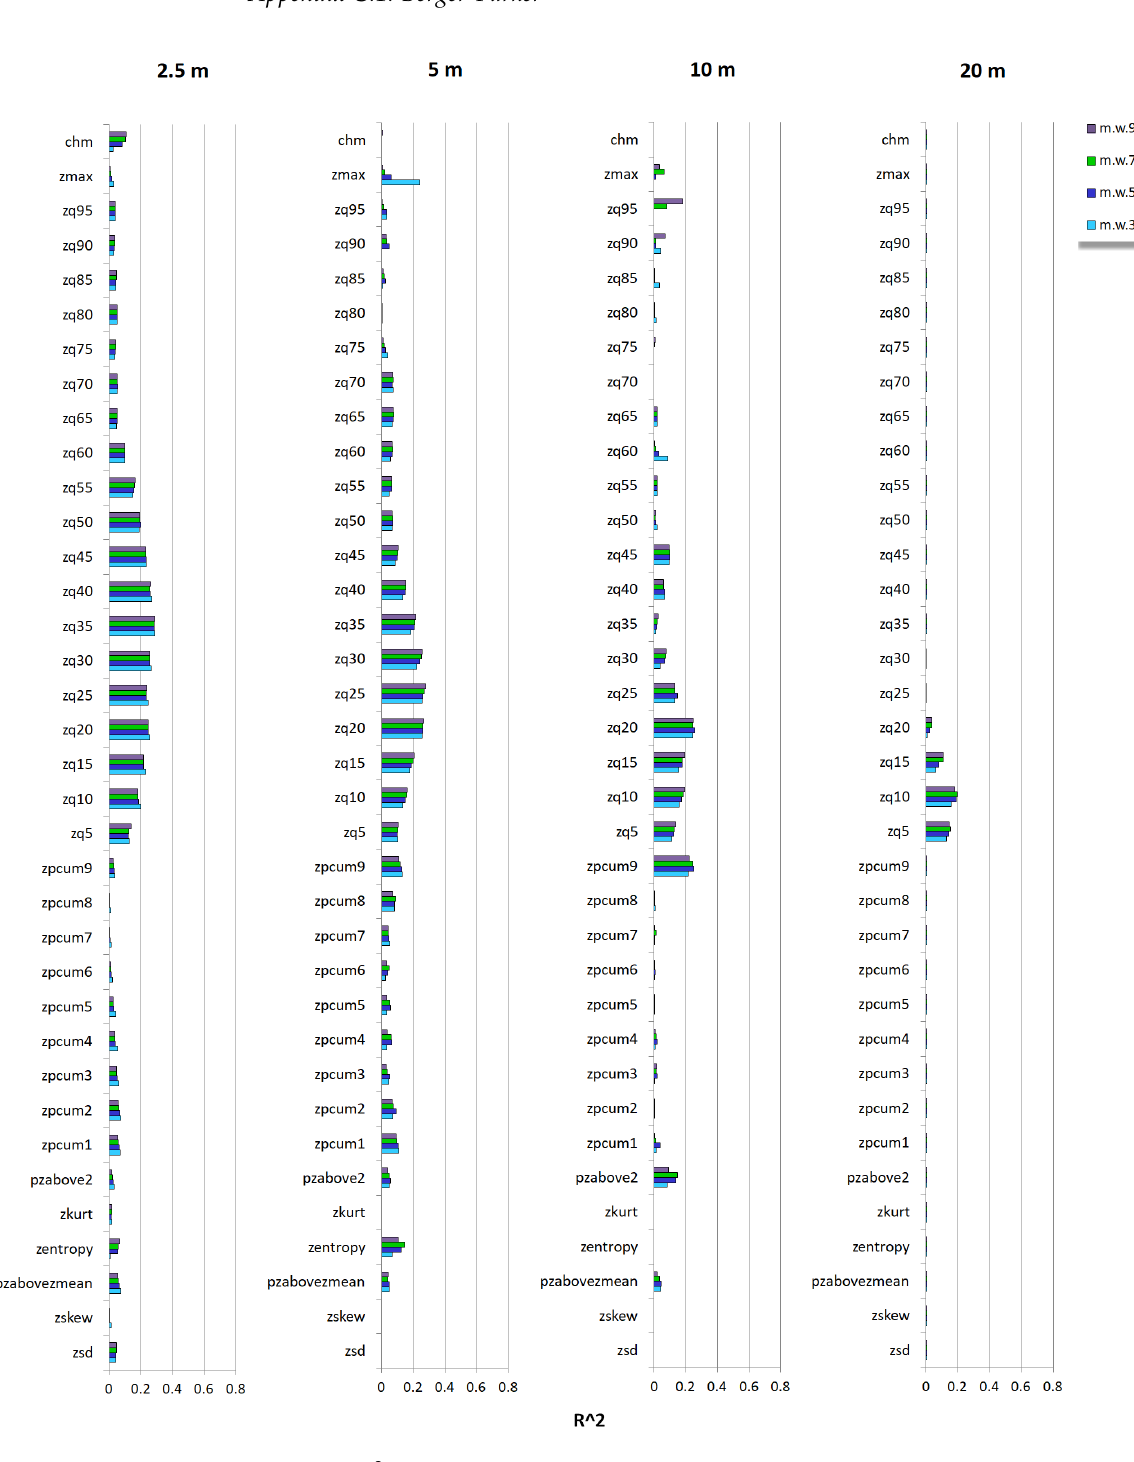
Figure A3. Histograms concerning the R 2 values relative to the linear regression between Shannon’s H field index and the mean of the Berger–Parker’s matrices of each LiDAR metric and for each MW (San Genesio/Jenesien study